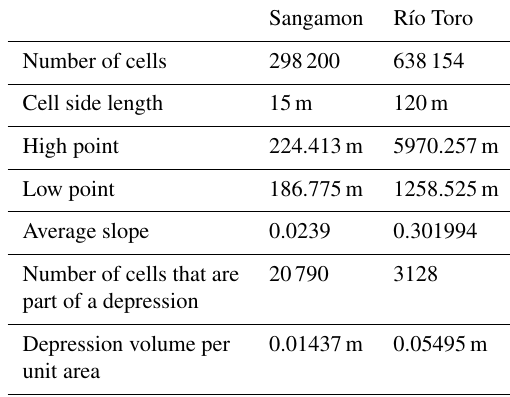
Table 1. Characteristics of the two study sites.